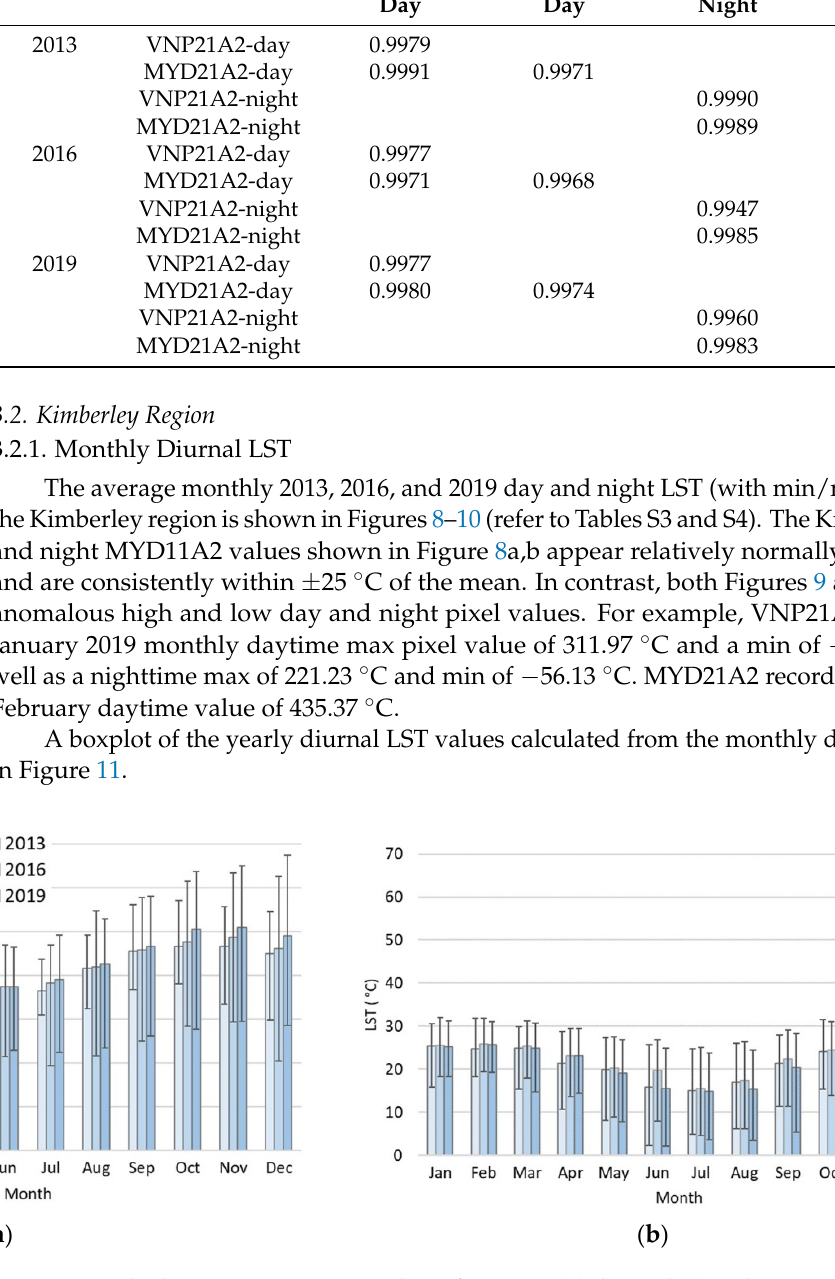
Figure 8. Kimberley MYD11A2 mean and min/max LST: ( a ) day and ( b ) night.